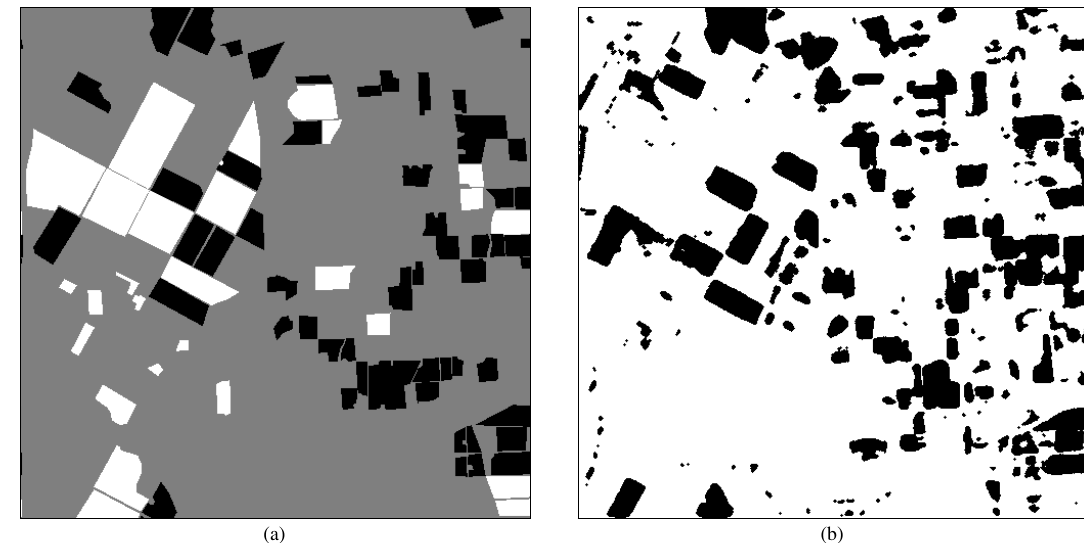
Figure 4. Bay Area scene: (a) reference image (white - unchanged, black - changed, gray - unknown), and (b) CD map obtained by the proposed method.